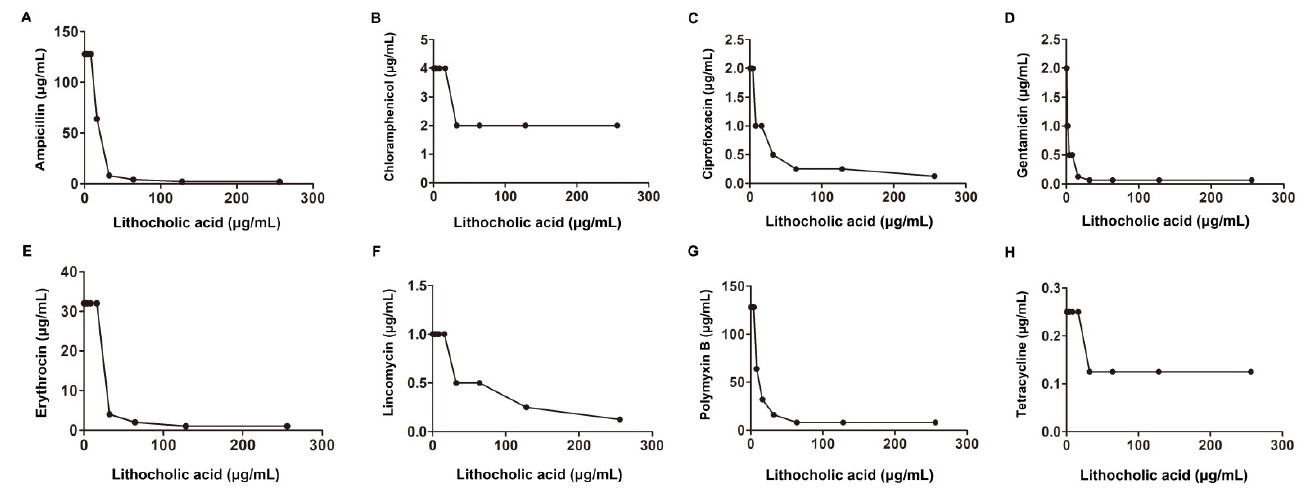
Figure 3. Interaction of LCA with Amp, Ery, Genta, Cip, Lin, Tet, Cpl and Pmb against S. aureus ( A – H ).